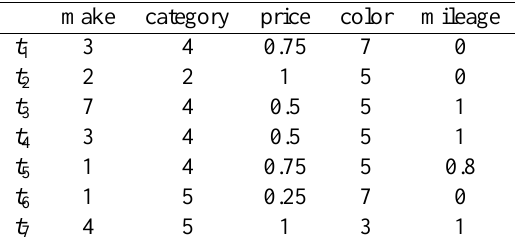
Table 2. Scores obtained by the values from car (Example 2a).